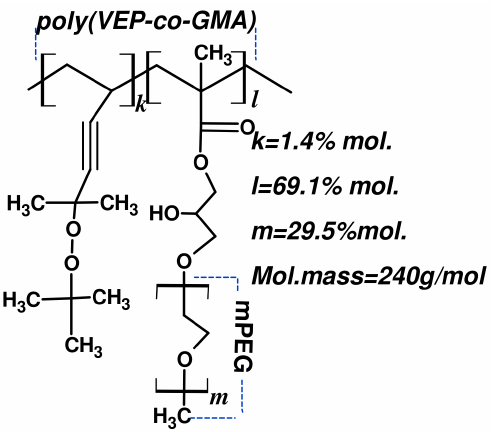
Figure 1. Assumed structure of the